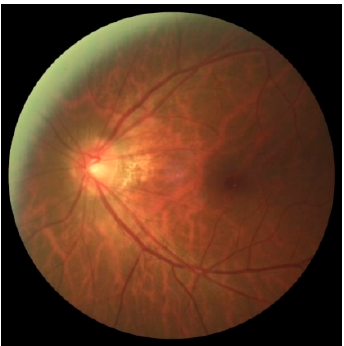
Figure 5. Photo V0002.jpg reduced to 25% of the original size.